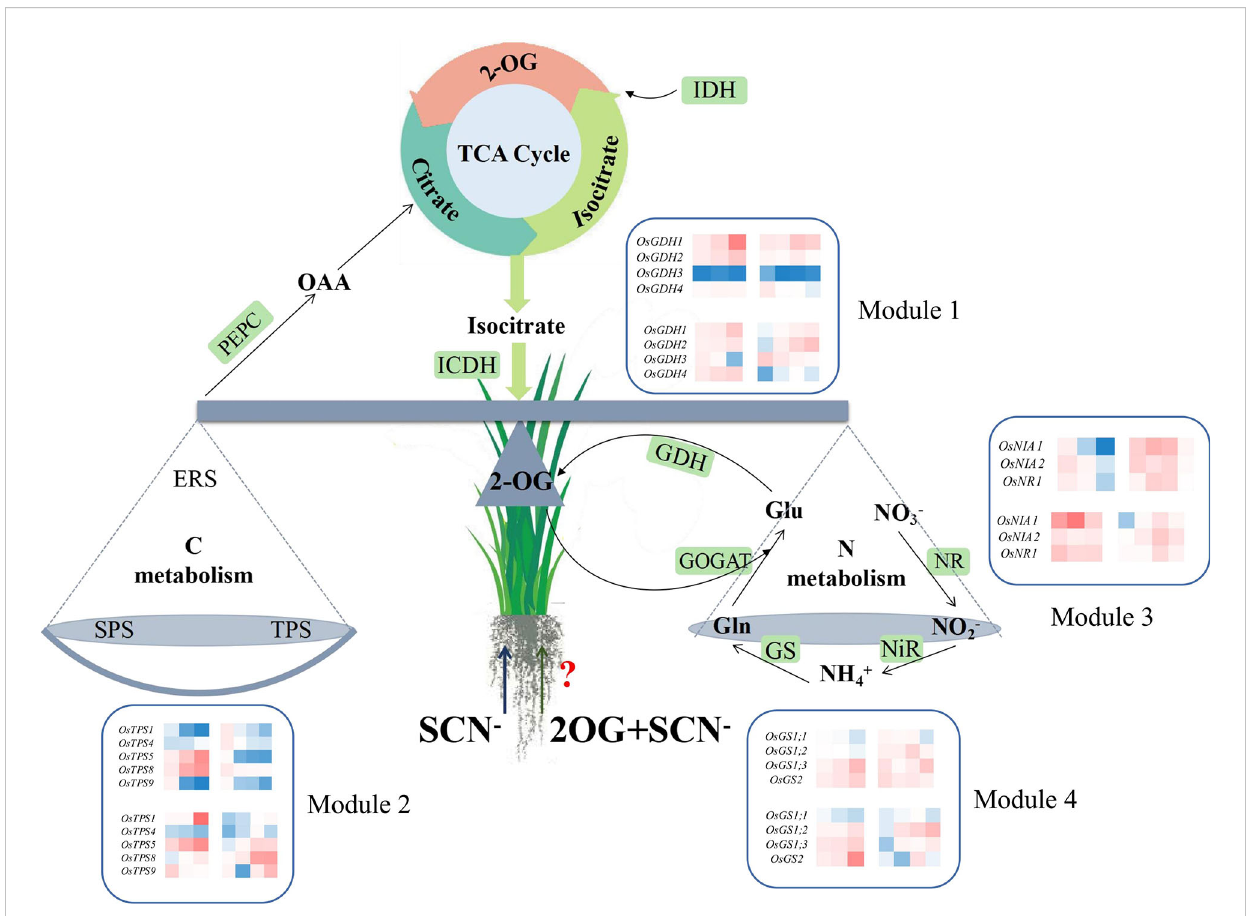
FIGURE 6 Overview of exogenous 2-OG-mediated CNM in rice tissues under SCN − stress. 2-OG, 2-oxoglutarate; CNM, carbon and nitrogen